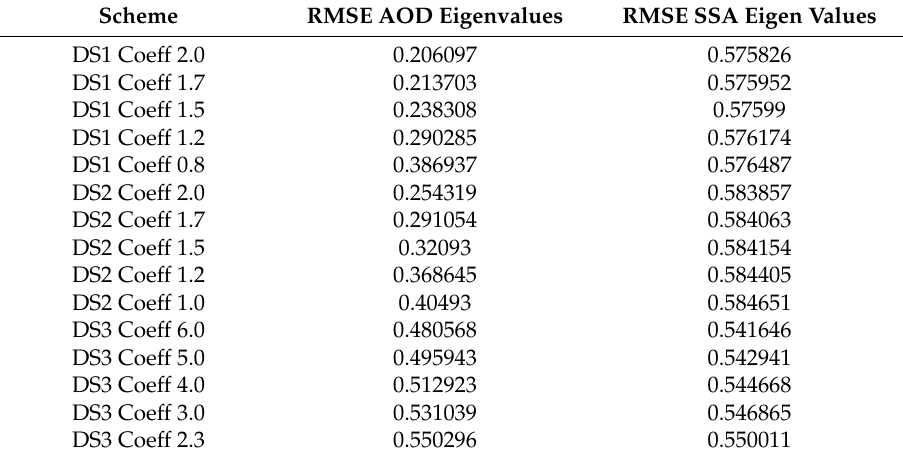
Table 8. Roots mean square error (RMSE) for AOD and SSA of eigenvalues between all the model simulations and MODIS for dust storm January